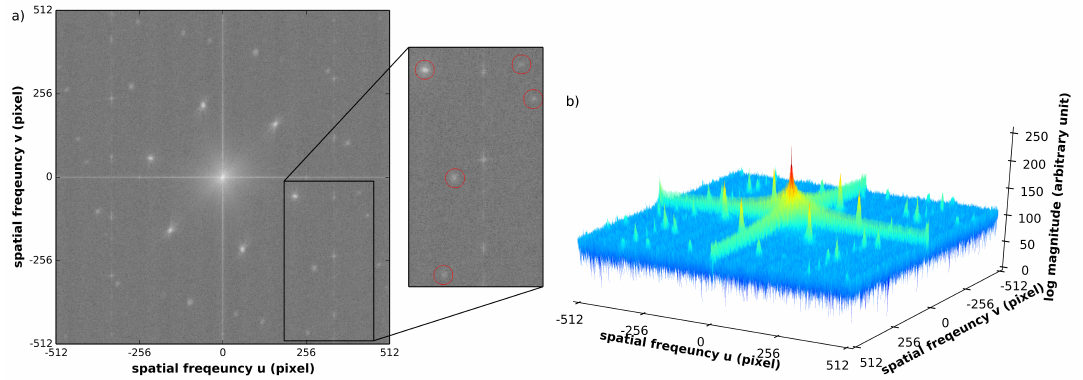
Figure 2. ( a ) Fourier spectrum of the HS image at wavelength 510 nm corresponding to Figure 1a. The affected components are marked by red circles for the zoomed area; and ( b ) Fourier spectrum presented as a 3D